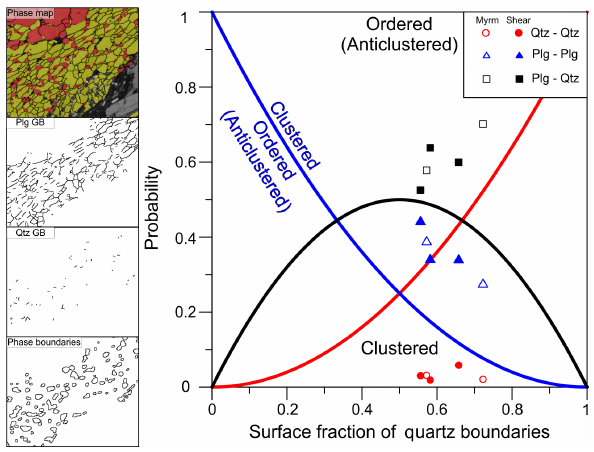
Figure 6. Image analysis of the phase spatial distribution in myrmekite. The diagram reports phase- and grain-boundary frac- tions in pristine and sheared myrmekite. Continuous curves repre- sent the theoretical probability of phase- and grain-boundary frac- tion as a function of Qtz content expected for a random distribution in a two-phase aggregate. The small maps on the left-hand side re- port one of the analysed areas (Area C. Fig. 4), showing from the top to the bottom the phase map, the Plg grain boundaries, the Qtz grain boundaries, and the Plg–Qtz phase